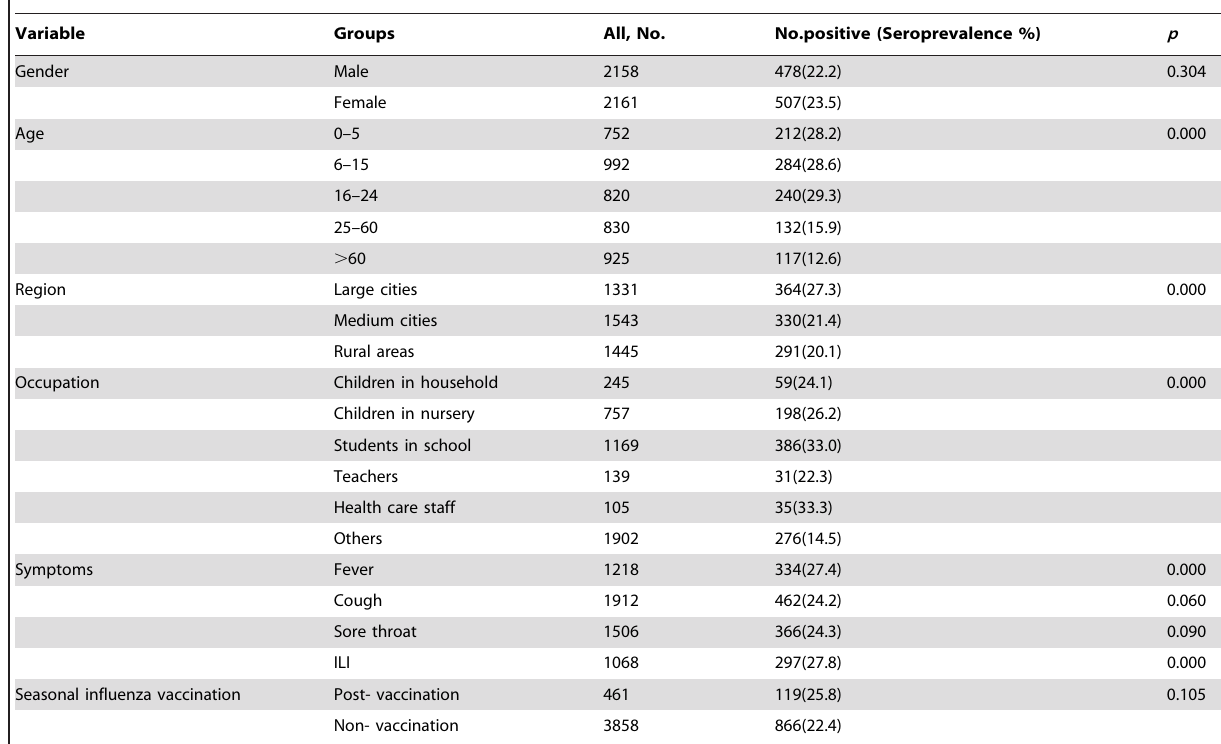
Table 1. Antibody response against pH1N1among different groups.